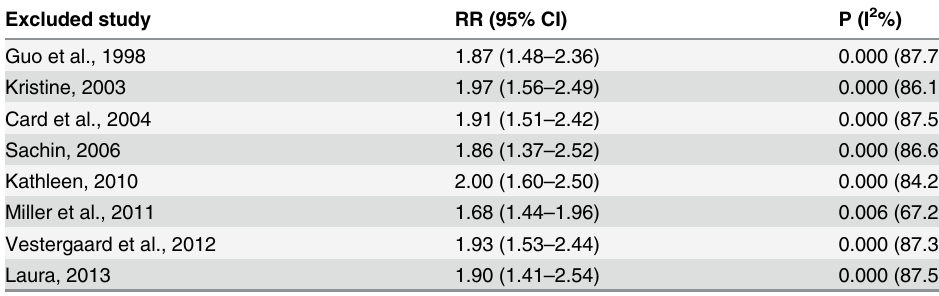
Table 3. Sensitivity Analysis of the Association between Opioid Use and Fracture